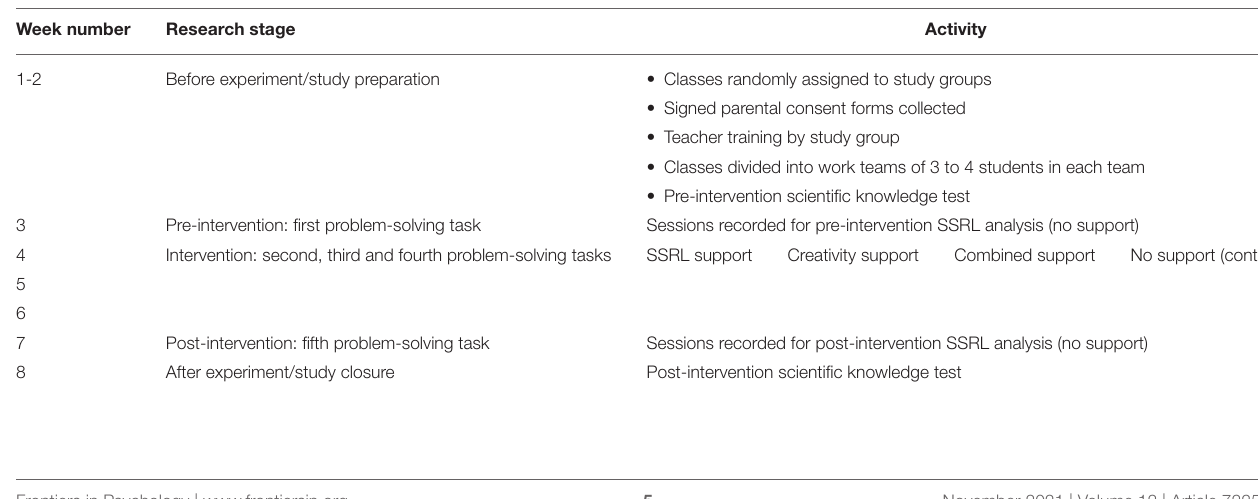
TABLE 1 | Summary of the study